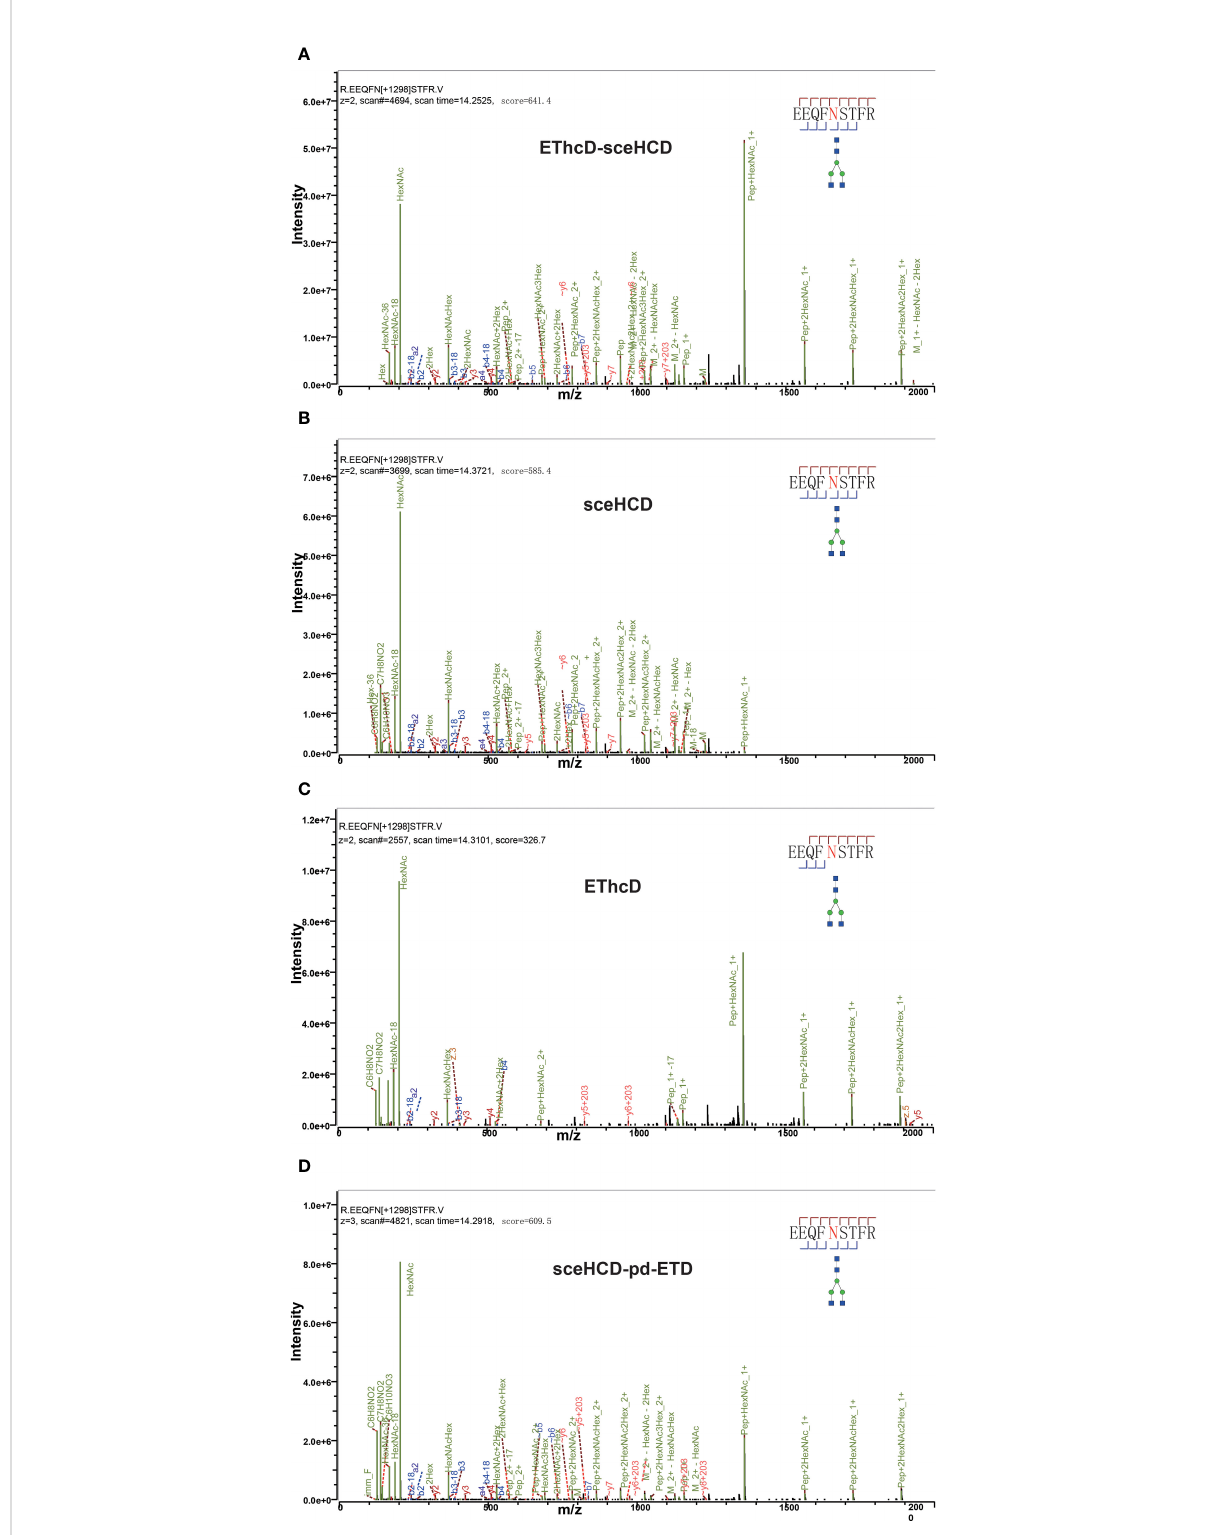
FIGURE 3 Comparison of EThcD-sceHCD (A) , sceHCD (B) , EThcD (C) , and sceHCD-pd-ETD (D) spectra of one intact N-glycopeptide [ 172 EEQF N STFR 180 - HexNAc(4)Hex(3)] from serum monoclonal